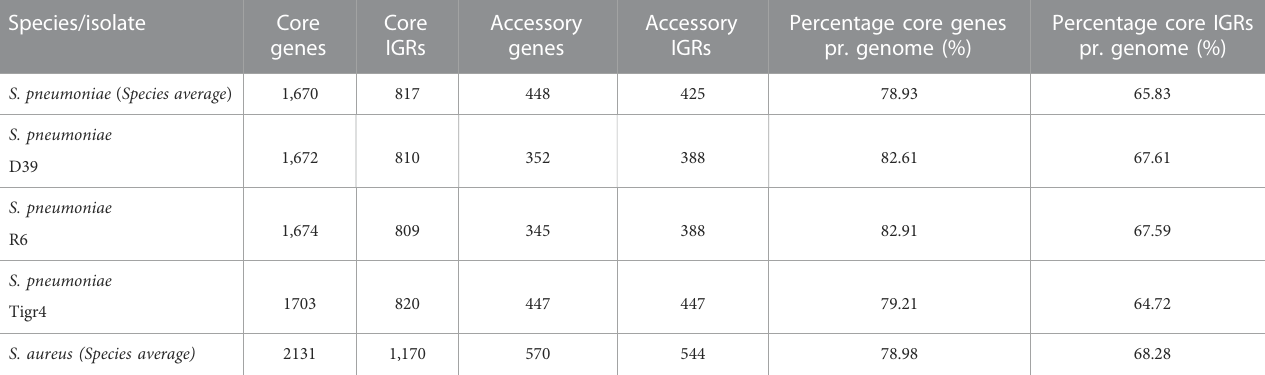
TABLE1ThenumberofgenesandIGRsinthecoreandaccessorygenomeinselectedgenomesandacrossthecollected pangenome,aswellasthepercentageofgenes and IGRs that are core. Species/isolate Core